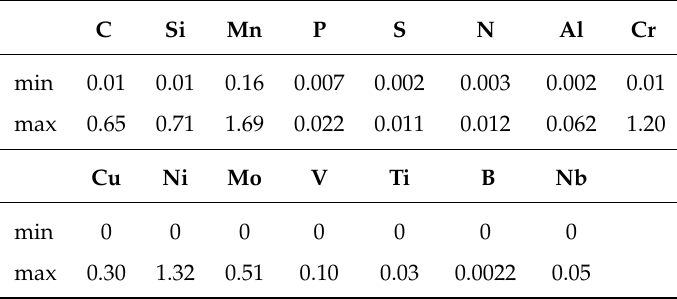
Table 2. The composition limits (in wt %) of the